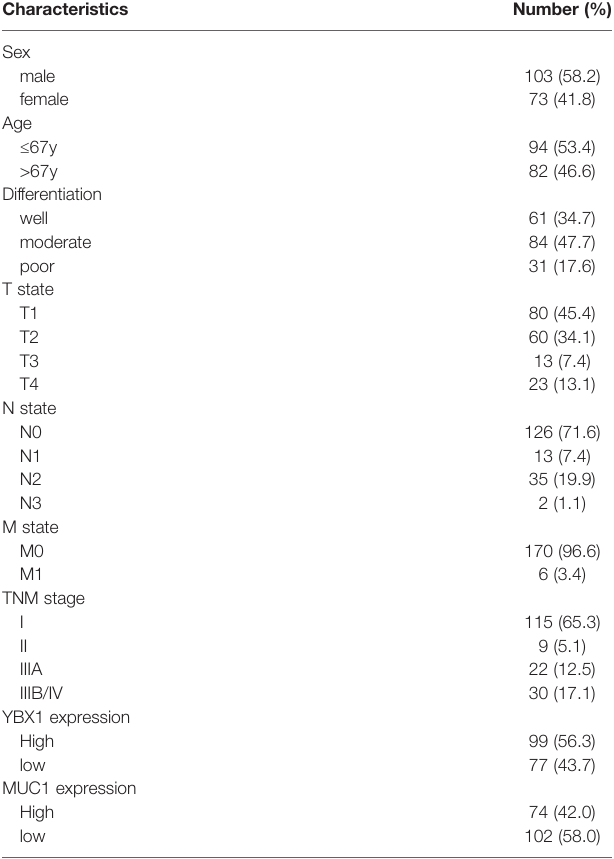
TABLE 2 | Genomic and epigenomic differences between nasopharyngeal carcinomas (NPCs), lymphoepithelioma-like carcinomas (LELCs) and EBV- associated gastric carcinomas